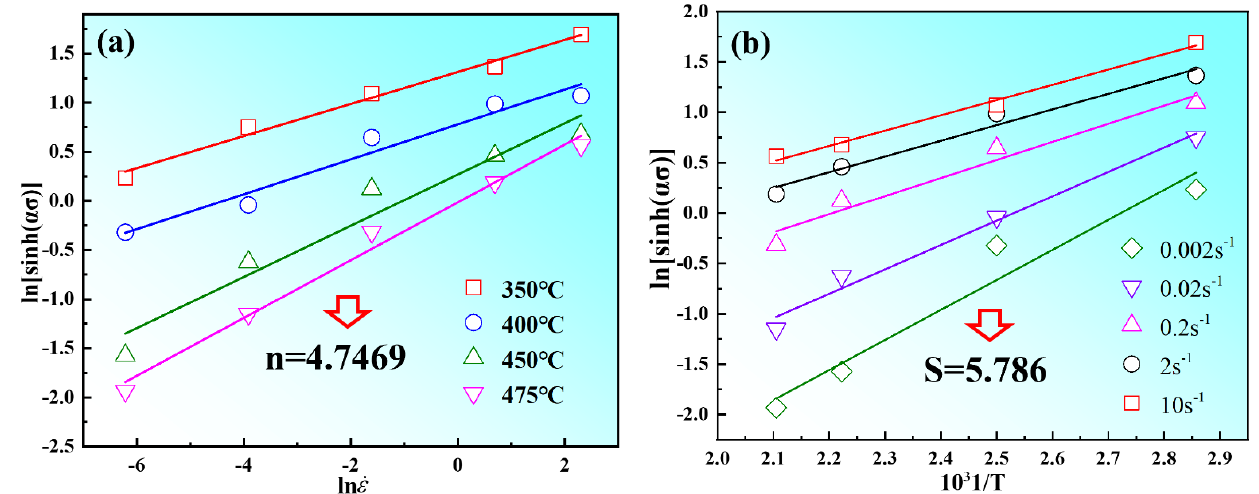
Figure 8. The linear relationship between stress and strain rate: ( a ) the relationship between ln ( sinh ( ασ )) and ln 𝜀̇ ; ( b ) the relationship between ln ( sinh ( ασ )) and 1/ T .